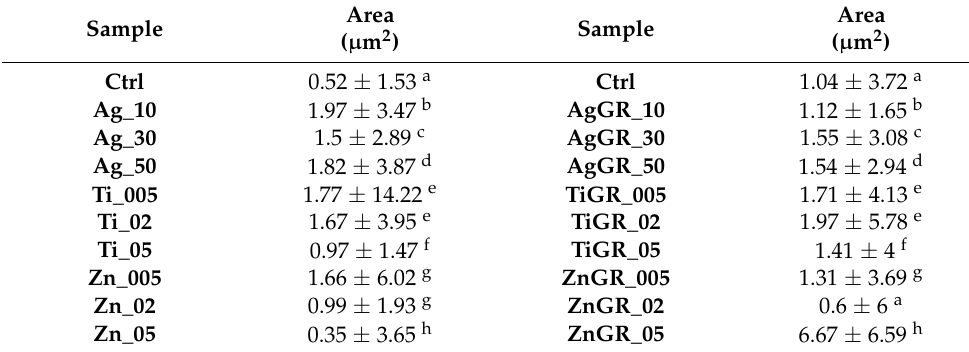
Table 7. Total fissure